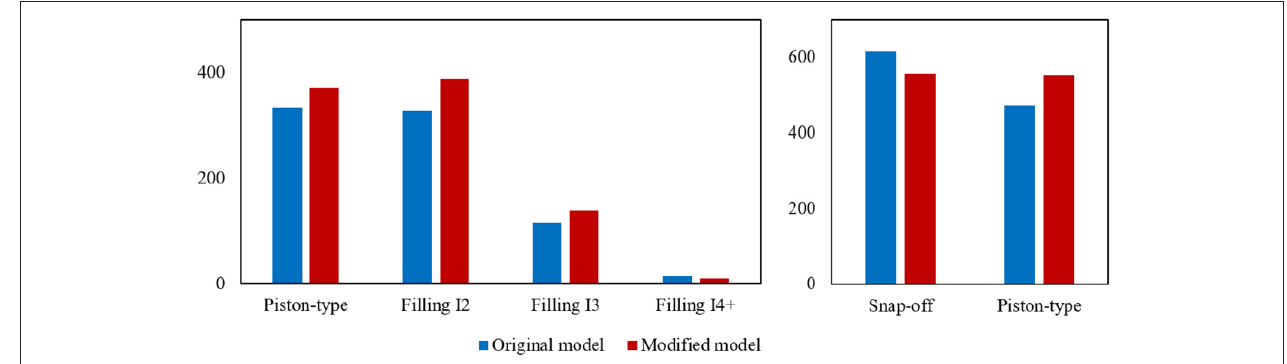
FIGURE 10 | Statistics of number of pore-level events during imbibition process in pore-bodies (left) pore-throats (right) of the Berea sandstone